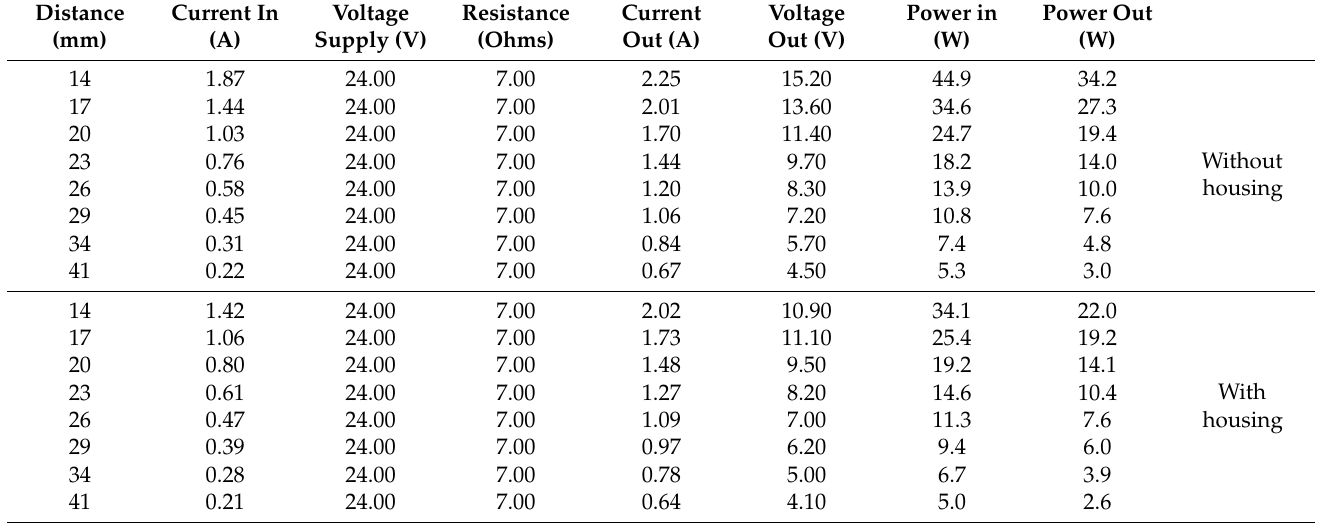
Table 12. Power over distance: electric parameters of the 24 V